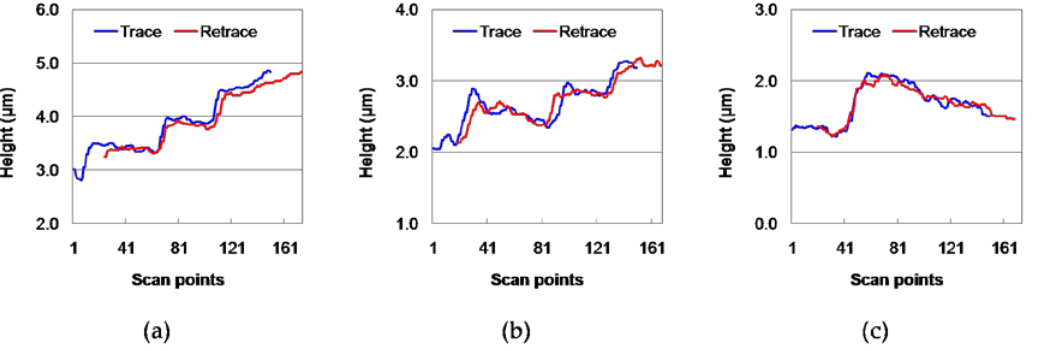
Figure 12. Line scans for trace and retrace extracted from AFM images in Figure 10: ( a ) Trace and retrace of line 75 extracted from Figure 11a,b, respectively; ( b ) Trace and retrace of line 75 extracted from Figure 11c,d, respectively; ( c ) Trace and retrace of line 75 extracted from Figure 11e,f, respectively.